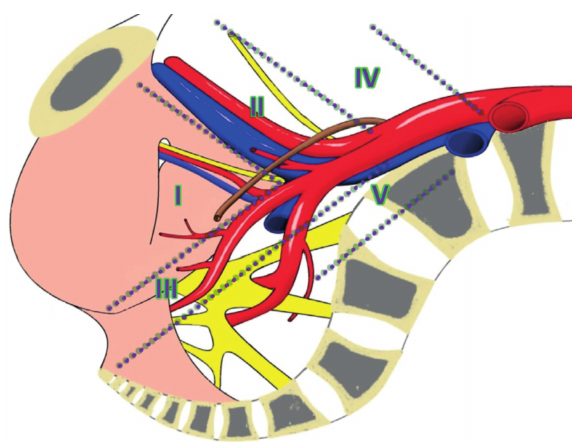
Figure 2 – Anatomical areas for the definition of the extent of